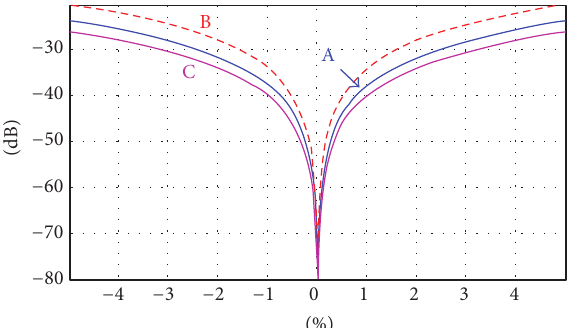
Figure 21: 𝐹( Z 𝑈 ) in dB at the tuning frequency, versus a relative capacitance variation of a single adjustable impedance device con- tributing to C 𝑈 : curve A if its initial value is 𝐶 𝑈𝐺 ; curve B if its initial value is 𝐶 𝑈𝑁 ; curve C if its initial value is 𝐶 𝑈𝐹